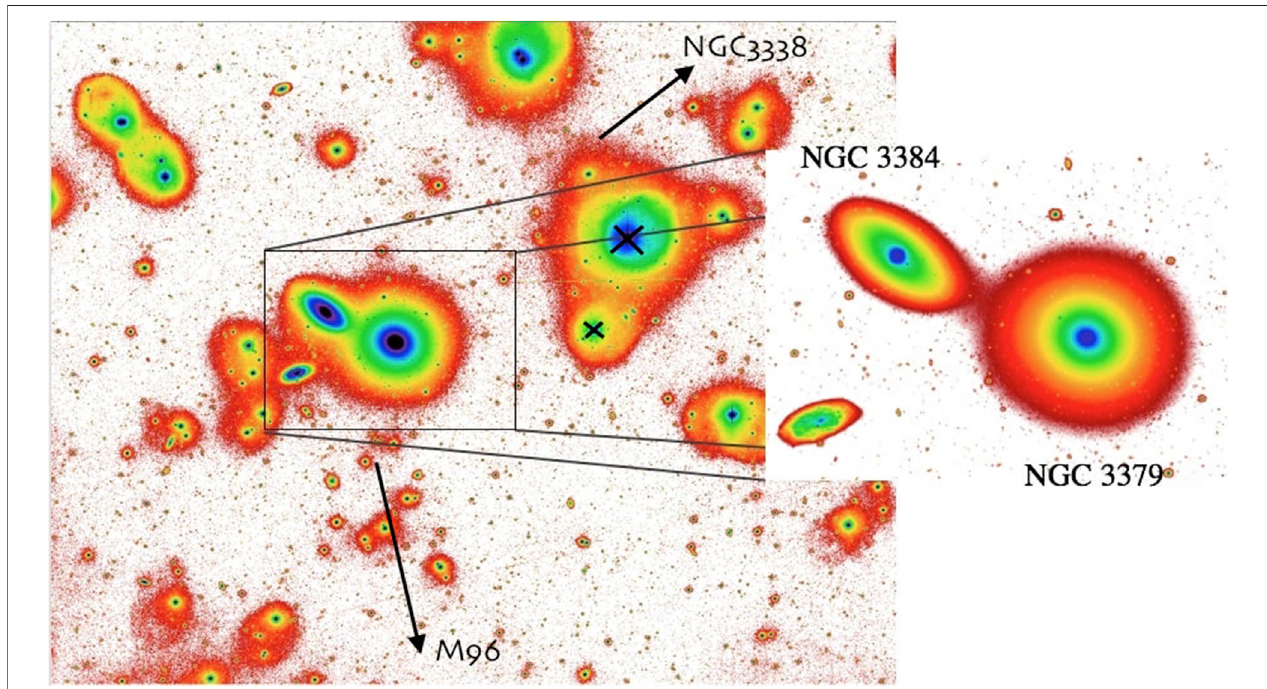
FIGURE2| DeepVSTimage, of1.34×1.05squaredegree,inthe r bandcentredonNGC3379,usedfortheanalysisdescribed inthispaper.NorthisupandEast istotheleft.Theblackcrossesmarkthecenterofthetwobrighterstarsinthe fi eld.ThetwoblackarrowsrepresentthedirectionofM96andNGC3338,beingthesetwo other brighter galaxies of the Leo I group. The two galaxies that compose the pair are indicated in the enlarged panel shown on the